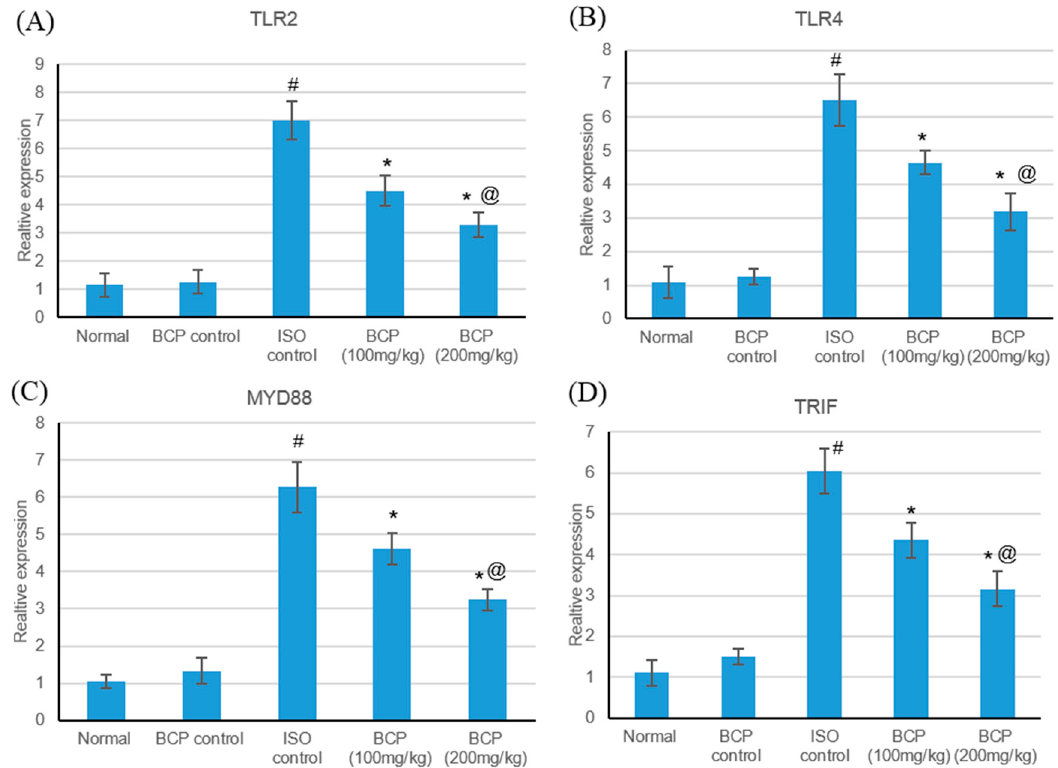
Figure 6. Effects of β -caryophyllene treatment (100, 200 mg/kg) for 21 days on the TLR pathway in ISO-induced myocardial infarction; ( A ) TLR2 mRNA, ( B ) TLR4 mRNA, ( C ) MyD88 mRNA, and ( D ) TRIF mRNA expression levels. All values were expressed as mean ± SD. ISO: isoproterenol; BCP: β -Caryophyllene and TLR: Toll-like Receptors. # indicates statistically significant from normal group, * indicates statistically significant from isoproterenol group, @ indicates statistically significant from β -caryophyllene (100 mg / kg) group ( p < 0.05) using one-way ANOVA followed by Tukey’s test as a post-hoc analysis.